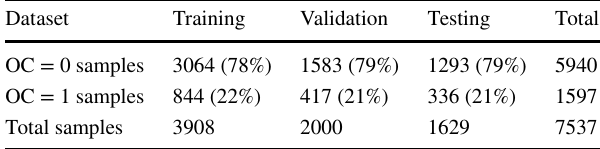
Table 2 Office room occupancy